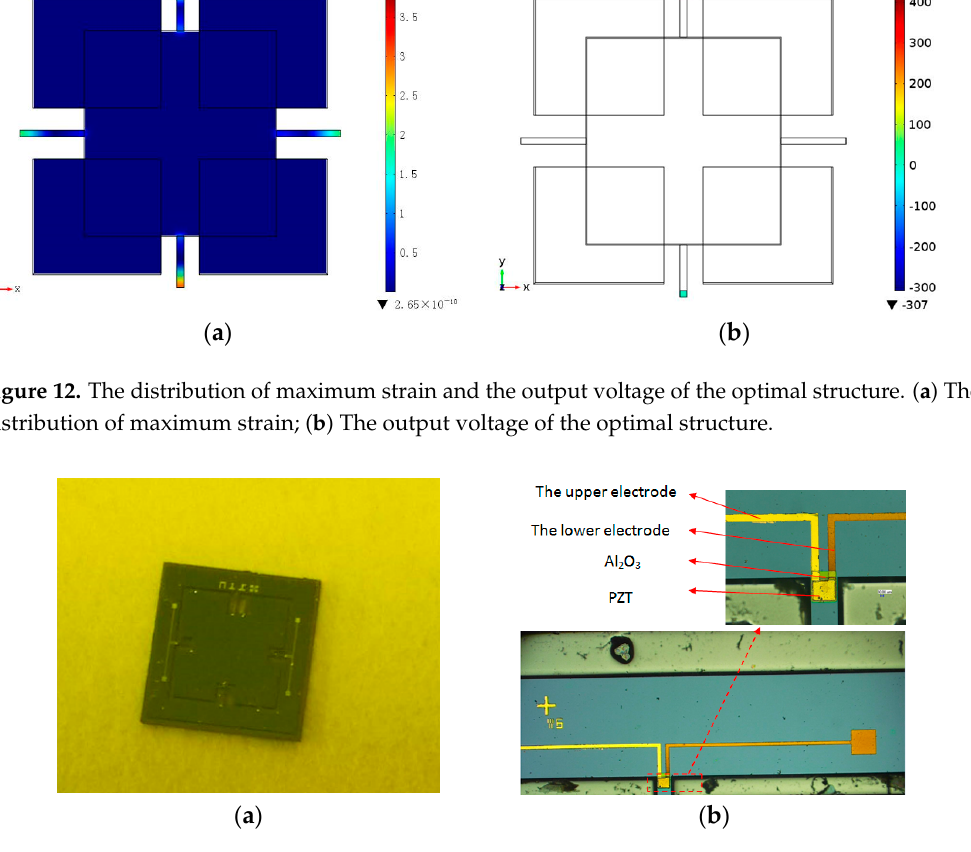
Figure 13. Fabricated piezoelectric accelerometer chip and the enlarged view. ( a ) Fabricated piezoelectric accelerometer chip; ( b ) The enlarged view. Table 3. Dimensions of the final structure.